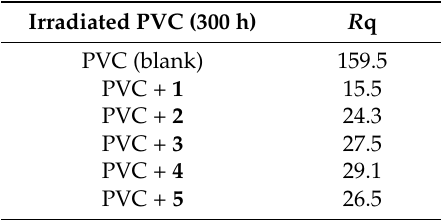
Table 4. The R q values for the PVC films after